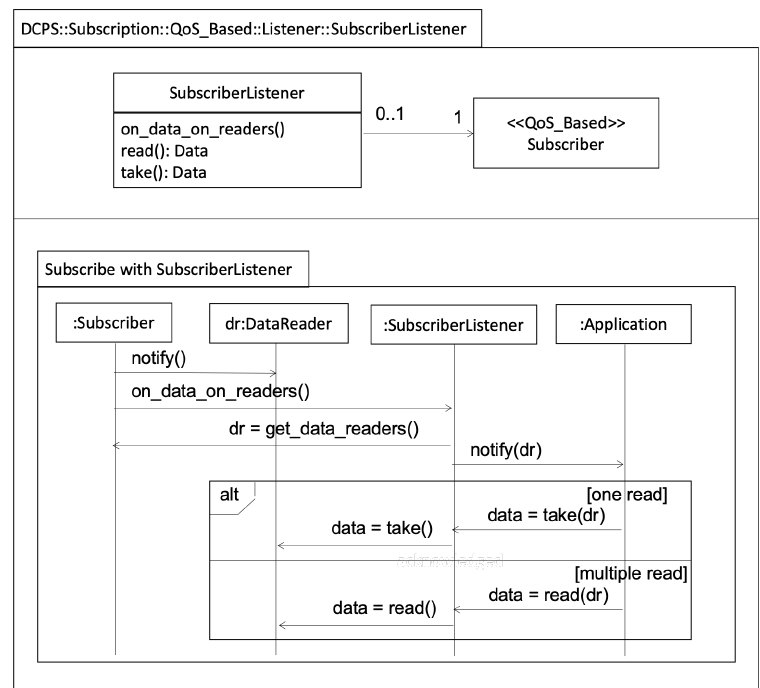
Figure 17. SubscriberListener feature.